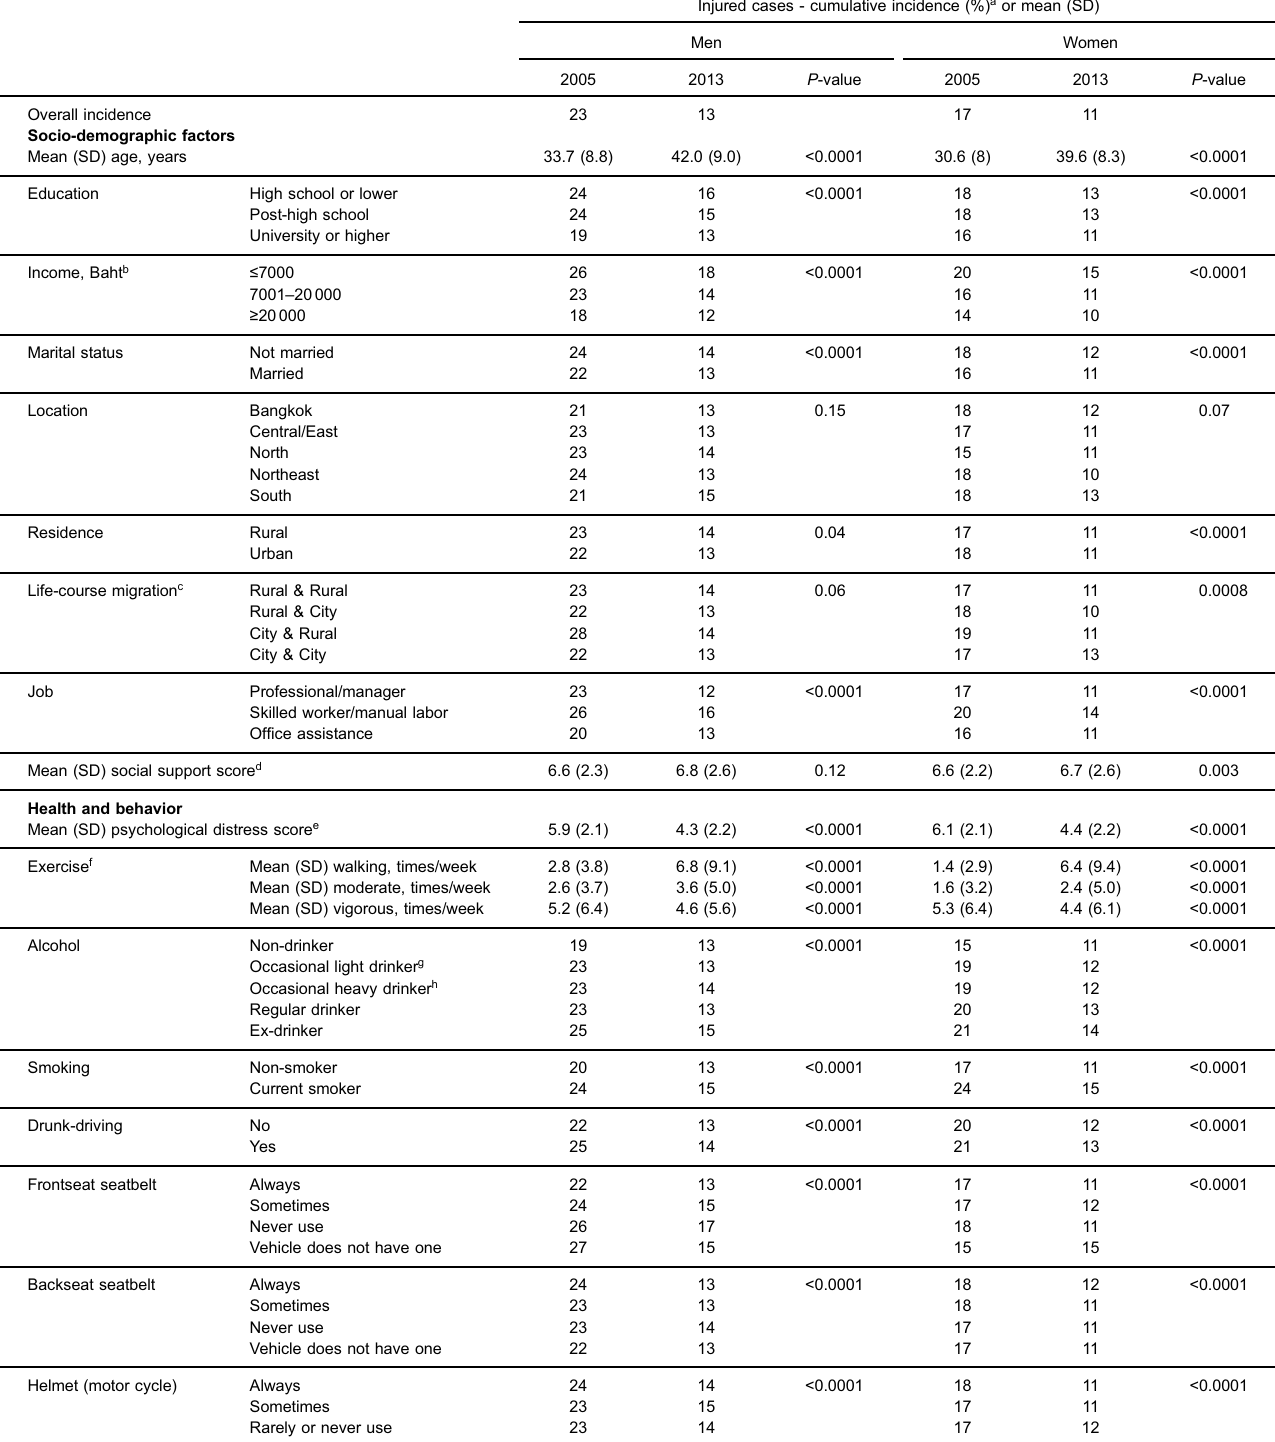
Injured cases - cumulative incidence (%) a or mean